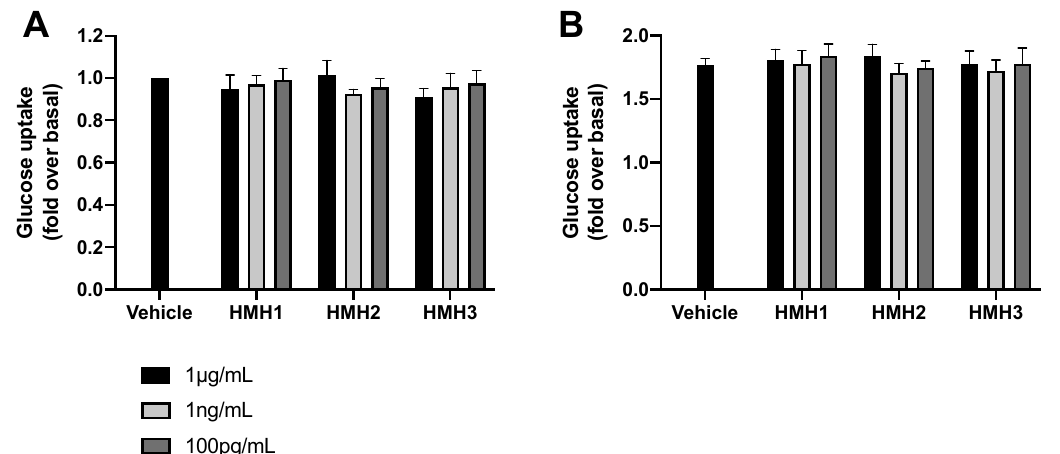
Figure 5. None of the HMH treatments impacted the glucose uptake in L6 myocytes. ( A ) Glucose uptake without insulin stimulation and ( B ) glucose uptake with insulin stimulation in L6 cells treated with HMHs at three concentrations (1 µg/mL, 1 ng/mL, and 100 pg/mL) ( n = 6, mean ± SEM). SEM: standard error of the mean.